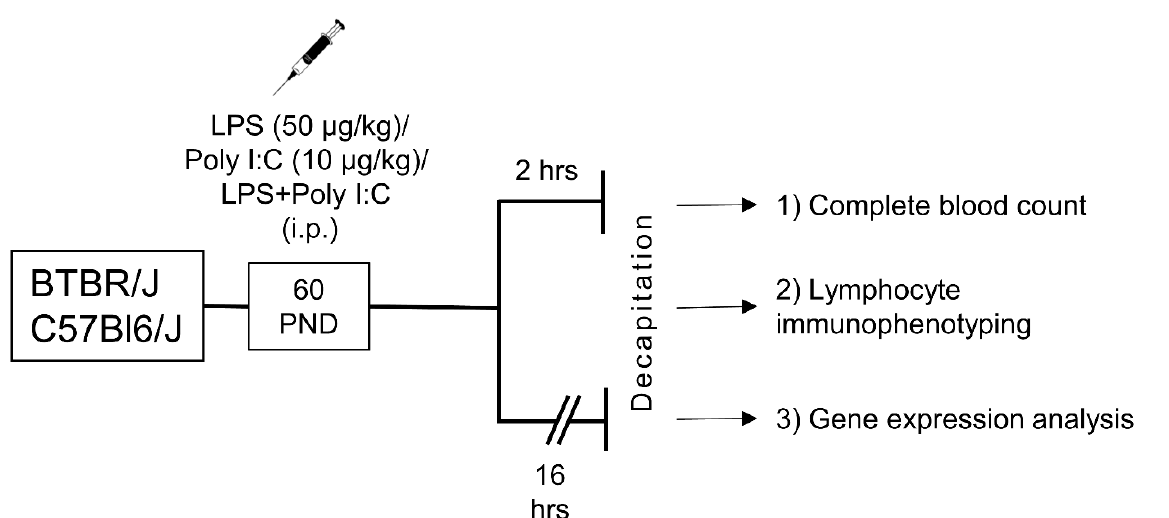
Figure 1. Experimental design. Adult male mice of both strains were injected with lipopolysaccharide (LPS), polyinosinic:polycytidylic acid (Poly I:C), or a combination thereof. After 2 or 16 h, blood and tissues were sampled for assays. PND-postnatal day.